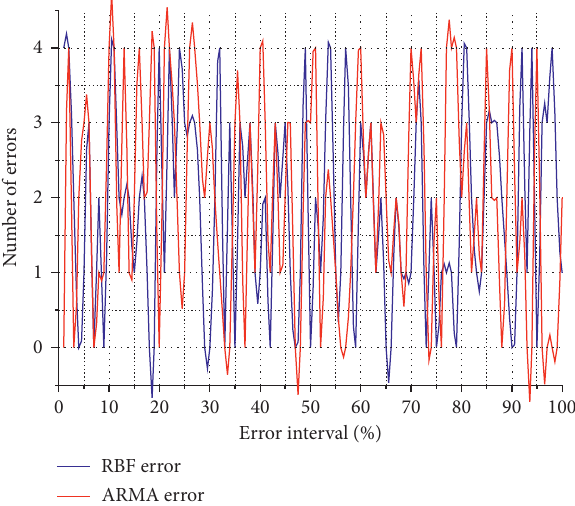
Figure 7: RBF and ARMA error distribution.